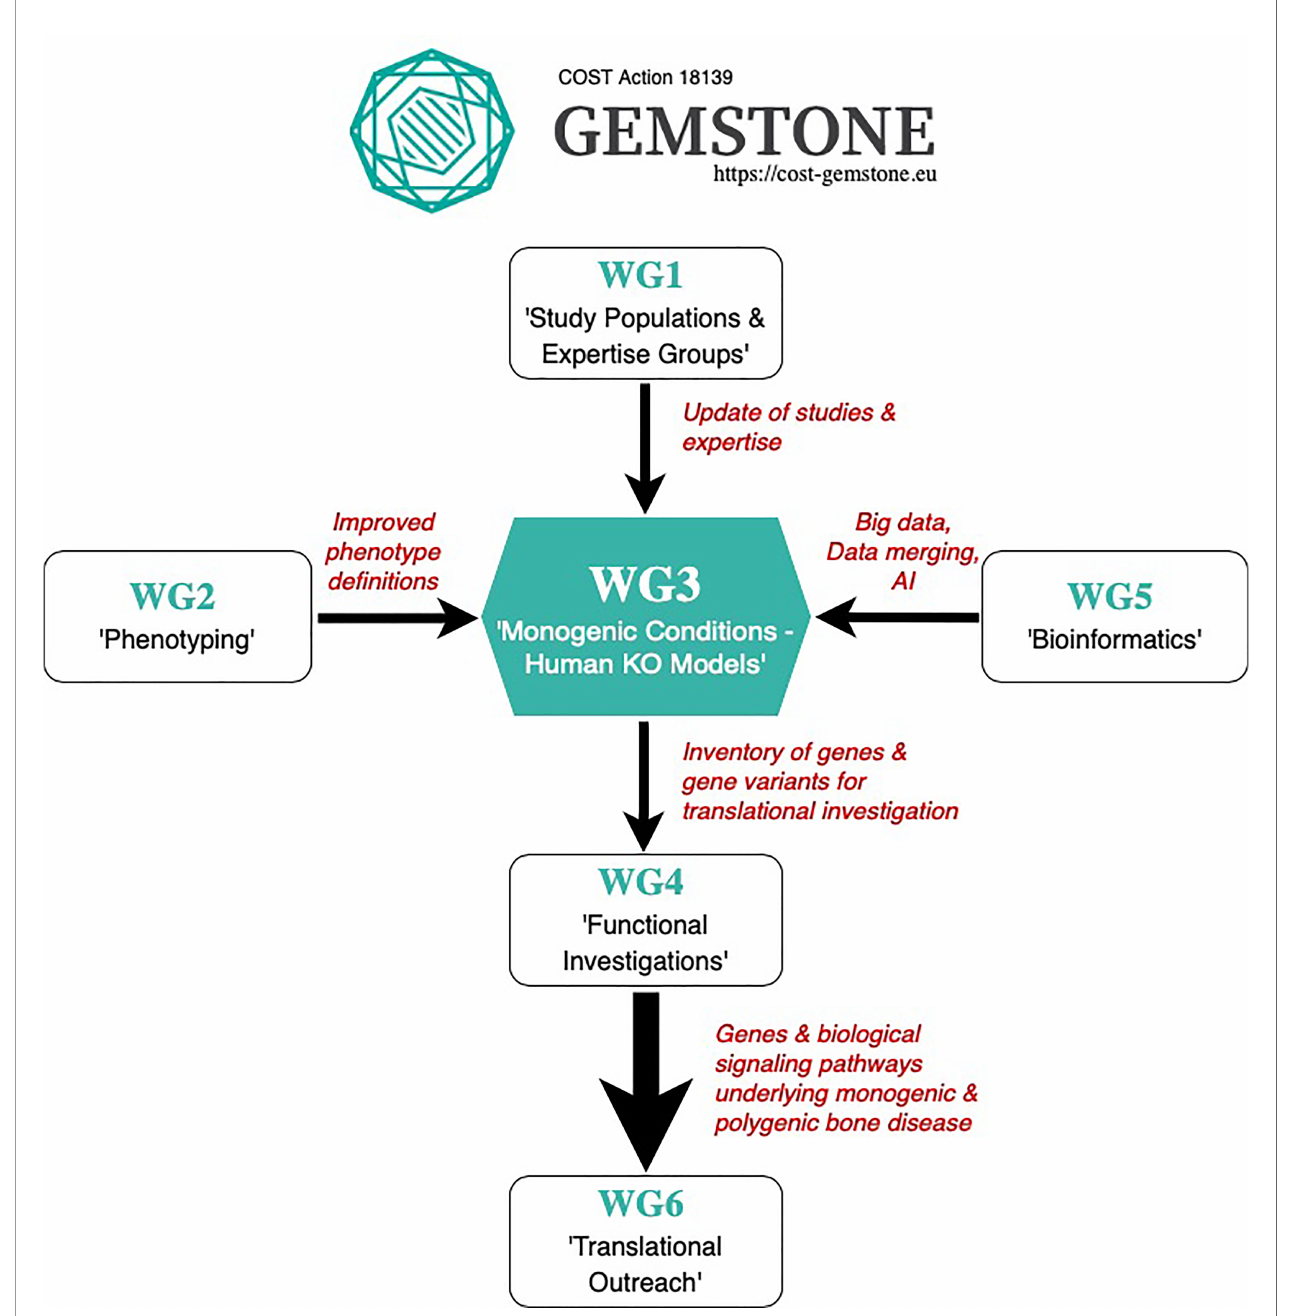
FIGURE 4 | GEMSTONE Working Group 3 Proposed